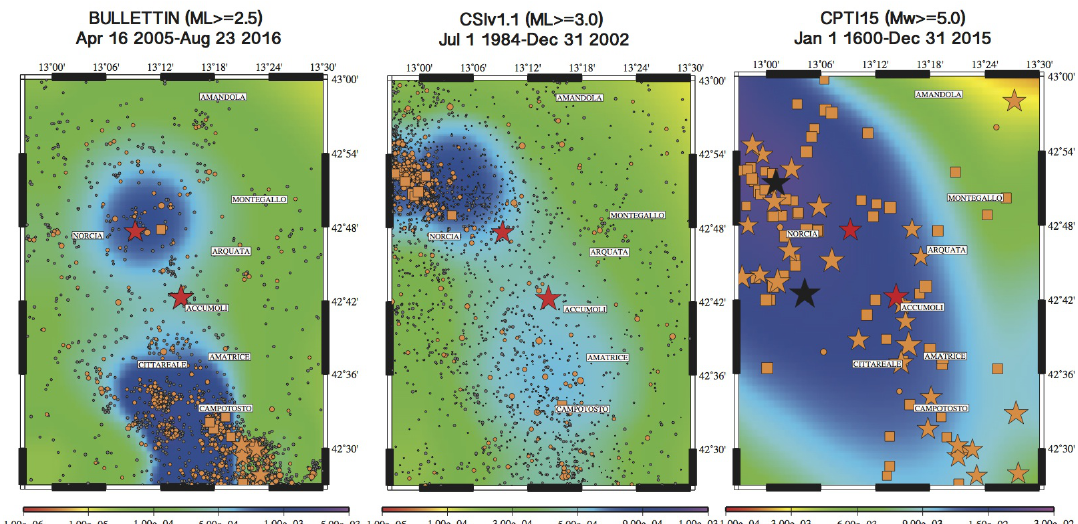
Figure 5: Comparison between the background spatial probability distributions obtained from three catalogs: the instrumental official INGV Bulletin, the CSIv1.1 and the historical CPTI15 catalogue. Gray circles mark the events below magnitude 2.5; orange circles, squares and stars mark the events with magnitude M < 4.0 , 4.0 ≤ M < 5.5 and 5.5 ≤ M < 6.5 , respectively. Black stars marks the events with M ≥ 6.5 . The red stars mark the ML 6.0 and ML5.4 events of the 2016 Central Italy sequence, respectively, both occurred at August 24. The magnitude scales are ML for the INGV bulletin and CSIv1.1 and Mw for CPTI15. The right panel shows the events above Mw4.0, for consistency with the other panels, but the background rate is estimated on events above